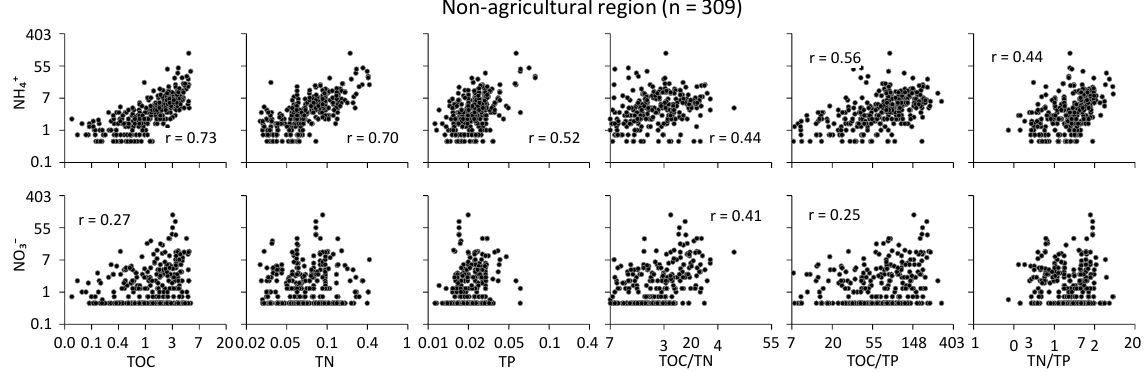
+ and NO − (mgNkg − 1 ), scatter plots of total organic C (TOC), total N (TN), total P (TP), and element ratios on the Figure 6. For NH 4 3 log-transformed scale in the non-agricultural region, where soil is used for conservation and under natural vegetation. The unit is expressed as percent C, N, or P by weight of soil. Pearson’s correlation coefficient is reported only when the trend is significant ( p < 0 . 05).